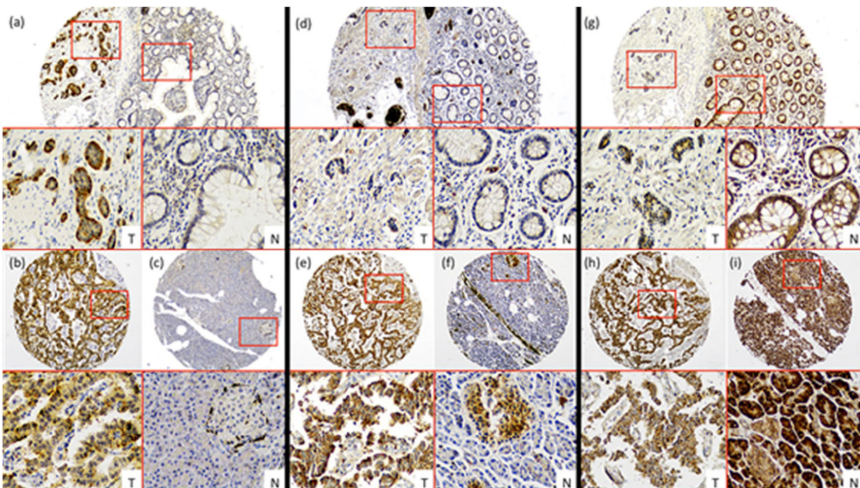
Figure 1. Characterization of nutrient transport markers in Gastroenteropancreatic neuroendocrine tumors (GEP-NETs). Representative cases of immunohistochemistry performed in a tissue microarray (TMA) of GEP-NET. ( a – c ) LAT-1 immunohistochemistry. ( d – f ) GLUT-1 immunohistochemistry and ( g – i )pVHLimmunohistochemistry. Firstrow: intestinaltumors( a , d , g ), tumor[T] / normal[N]zoneswith their respective magnification inset [T / N]. Second row: ( b , e , h ) pancreatic tumor and ( c , f , i ) normal tissue from the same tumor sample with their respective magnification inset [T / N]. Original magnification 4 × with 20 × digital zoom (insets).